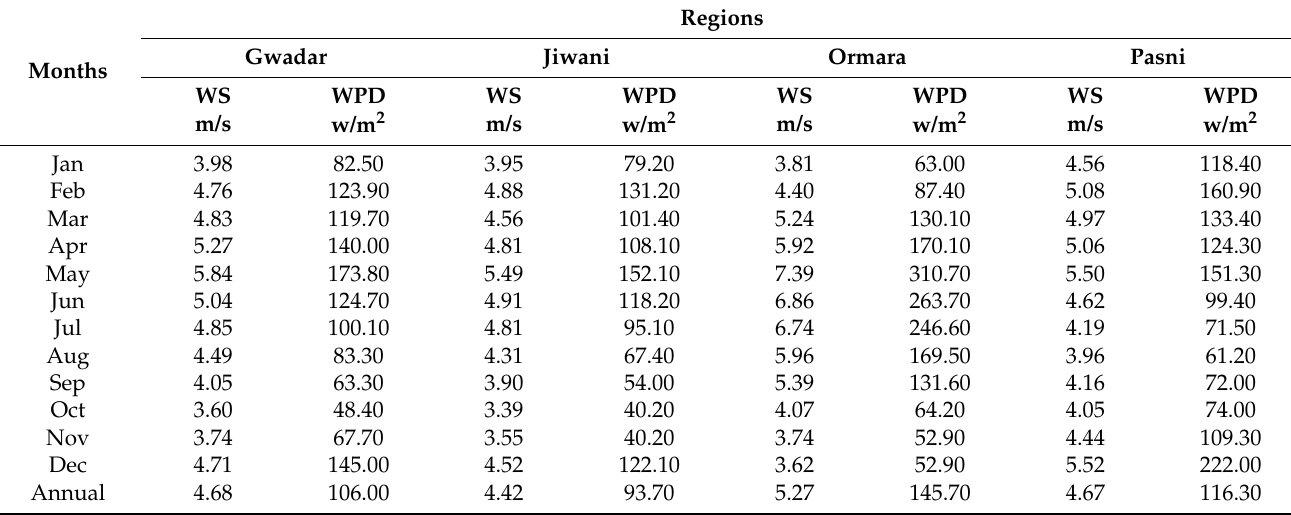
Table 9. Monthly and annual average WS and WPD for all regions.